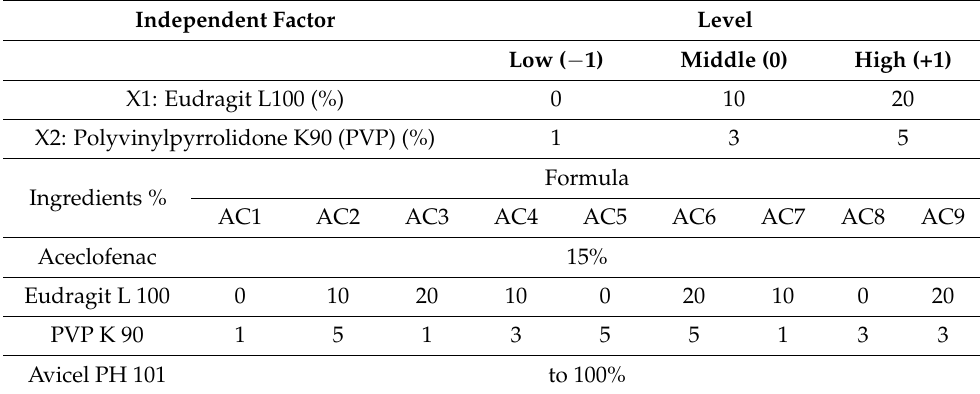
Table 1. Variables and composition in 3 2 full factorial design for AC-loaded matrix